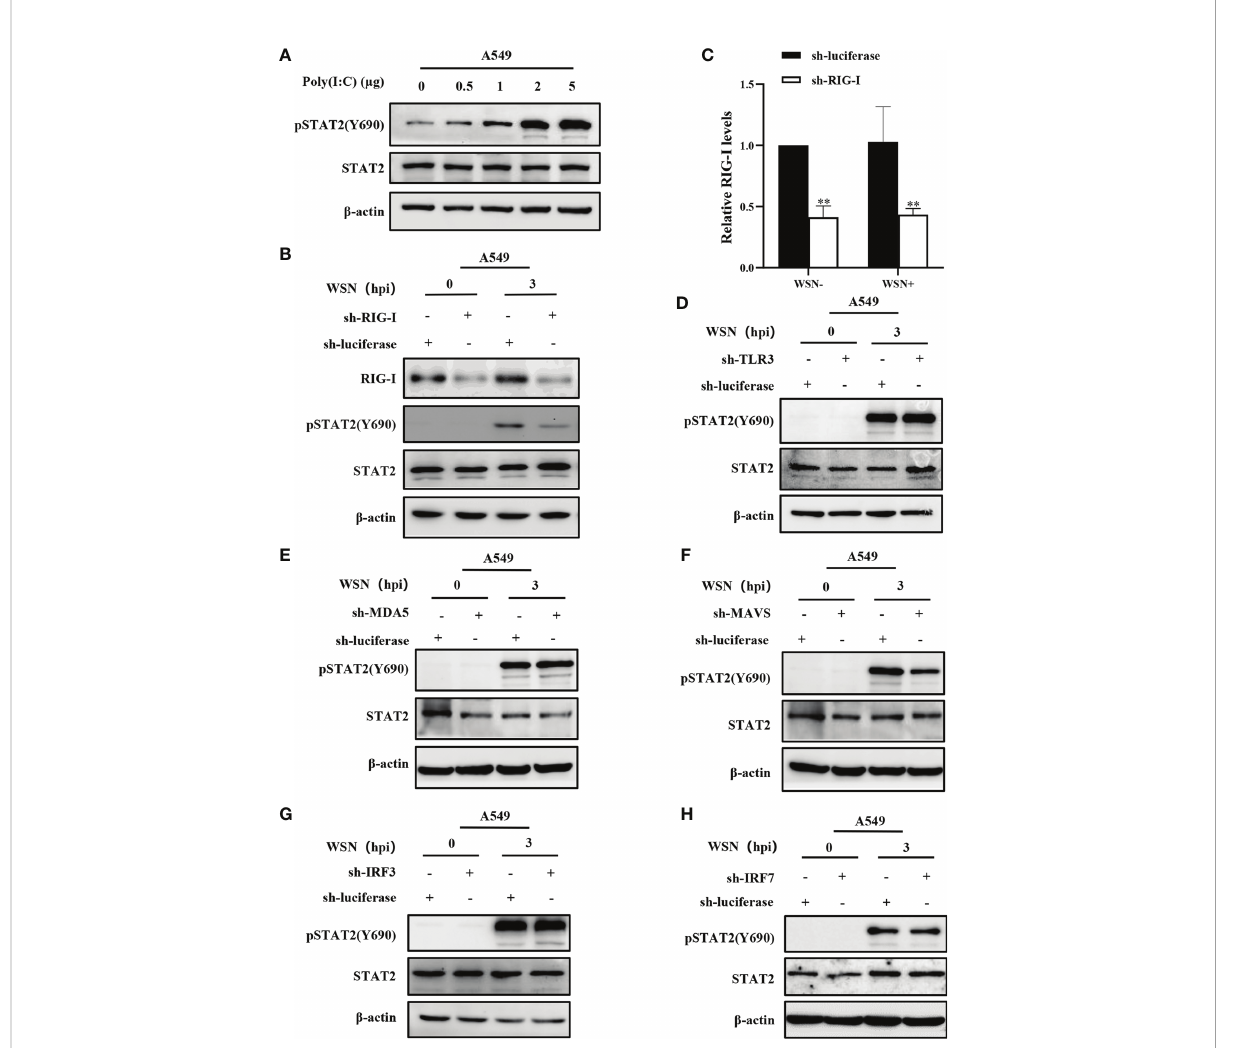
FIGURE 5 Early activation of STAT2 is mainly regulated by RIG-I/MAVS signaling. (A) A549 cells were transfected with different concentrations of Poly(I:C) for 6 h, and pSTAT2 were analyzed by Western blotting. (B ,C) Western blotting was performed to evaluate the indicated proteins in WSN- infected RIG-I or control (luciferase) knockdown A549 cells (B) . The RIG-I levels were quantitated by densitometry as described in B (C) . Error bars represent the mean ± SD from three independent experiments. **p < 0.01. (D – H) The sh-RNA based A549 cell lines stably expressing TLR3 (D) , MDA5 (E) , MAVS (F) , IRF3 (G) , IRF7 (H) , and control (luciferase) were infected with WSN (MOI =1) for 3 h Cell lysates were collected and pSTAT2 levels were detected by Western blotting (D – H) . The results shown in the fi gure are representative results of three independent